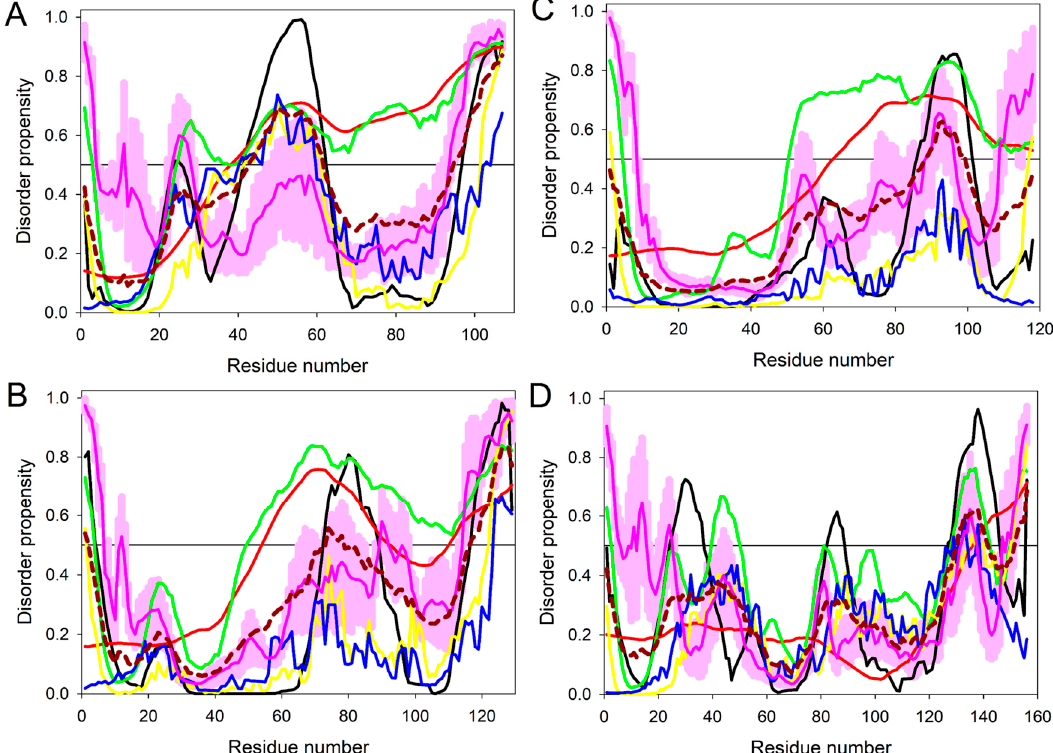
Figure 1. Evaluating intrinsic disorder propensity of protein effectors ( A ) MVLG_04106; ( B ) MVLG_05720; ( C ) MVLG_06175 and ( D ) MVLG_01732 by a series of per-residue disorder predictors. Disorder profiles generated by PONDR ® VLXT, PONDR ® VL3, PONDR ® VSL2, IUPred_short, IUPred_long, and PONDR ® FIT, are shown by black, red, green, yellow, blue, and pink lines, respectively. Dark red dashed line shows the mean disorder propensity calculated by averaging disorder profiles of individual predictors. Light pink shadow around the PONDR ® FIT shows error distribution. In these analyses, the predicted intrinsic disorder scores above 0.5 are considered to correspond to the disordered residues/regions, whereas regions with the disorder scores between 0.2